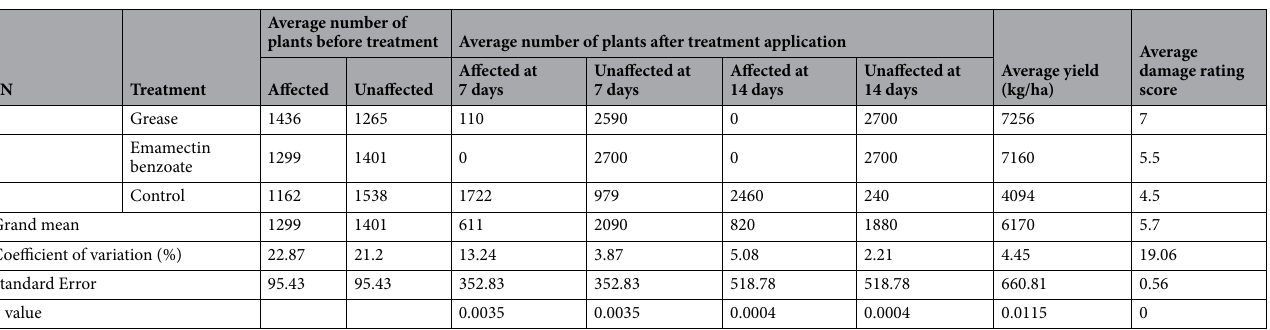
Table 3. Analysis of variance shows average grain yield, damage rating score, and number of affected and unaffected maize plants after grease and emamectin benzoate applications to control fall armyworm larvae in the winter season of 2020/2021. ANOVA was calculated based on three treatments and two replications. Two number after decimal is reduced to a single digit. P value calculated at 0.05% level of confidence.